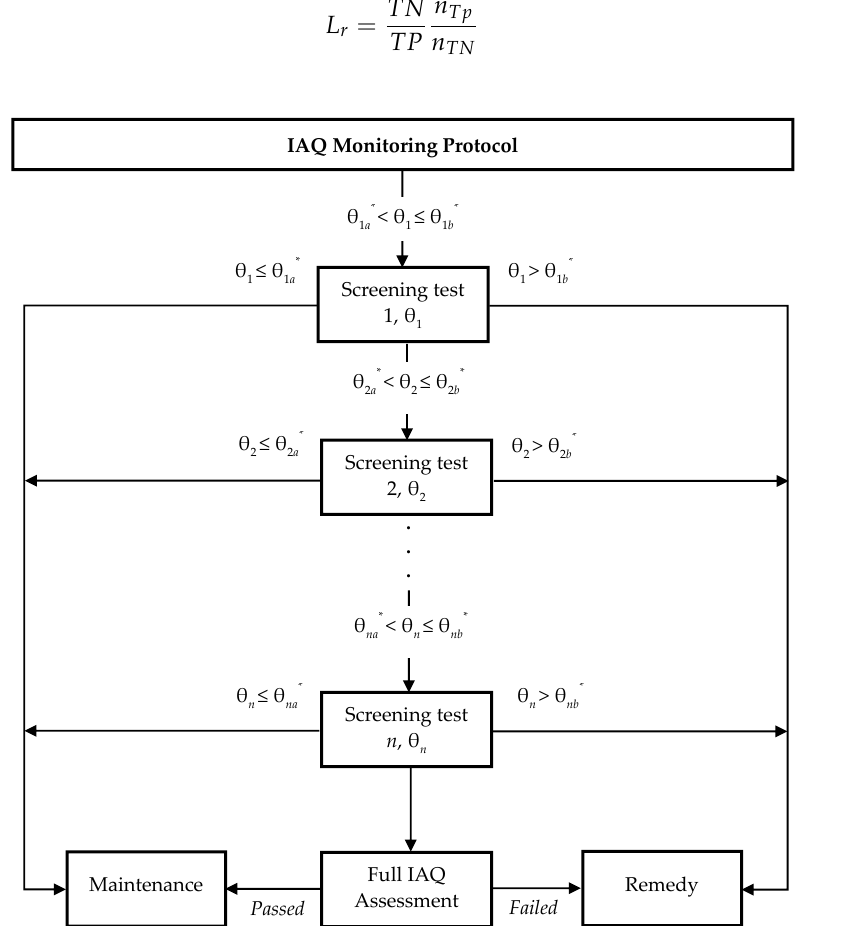
Figure 1. Screening and decision-making process for indoor air quality (IAQ) management.